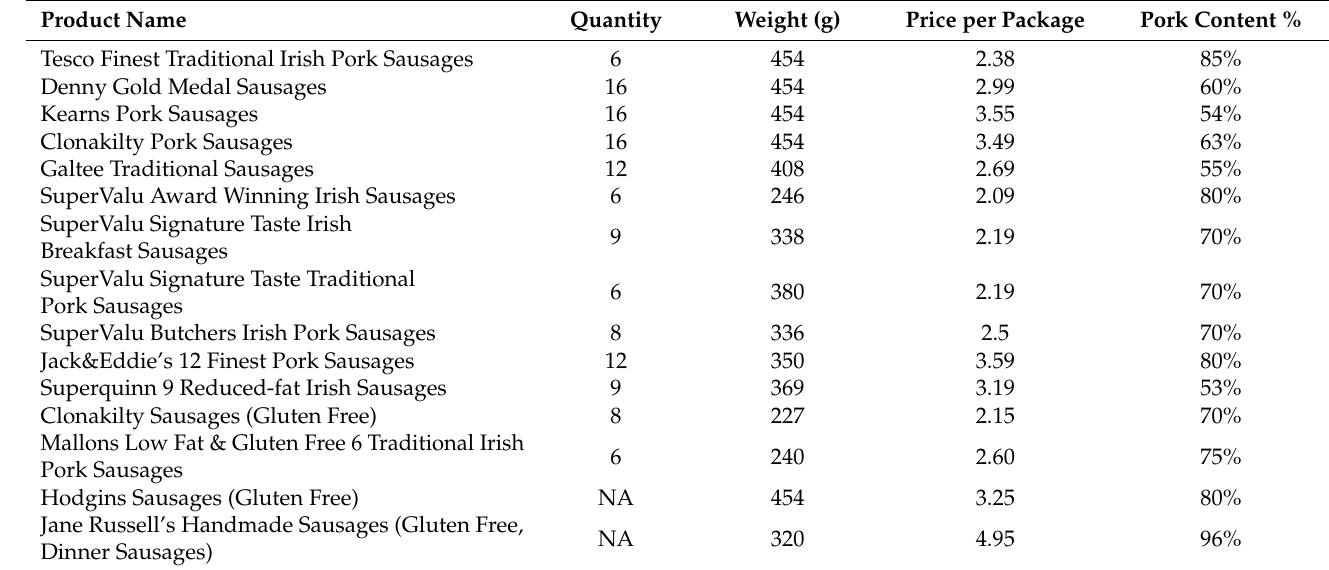
Table A1. An information summary of selected pork sausages available in Irish supermarkets.